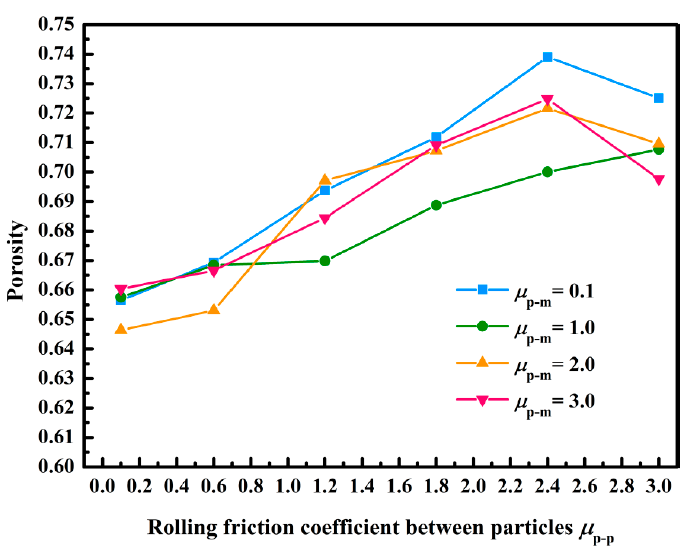
Figure 11. Impacts of the rolling friction coe ffi cient on porosity.